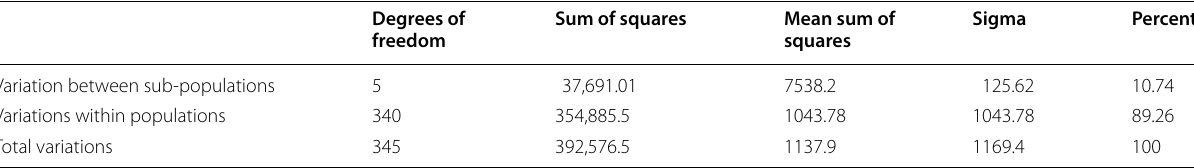
Degrees of Sum of squares Mean sum of Sigma Percent freedom squares